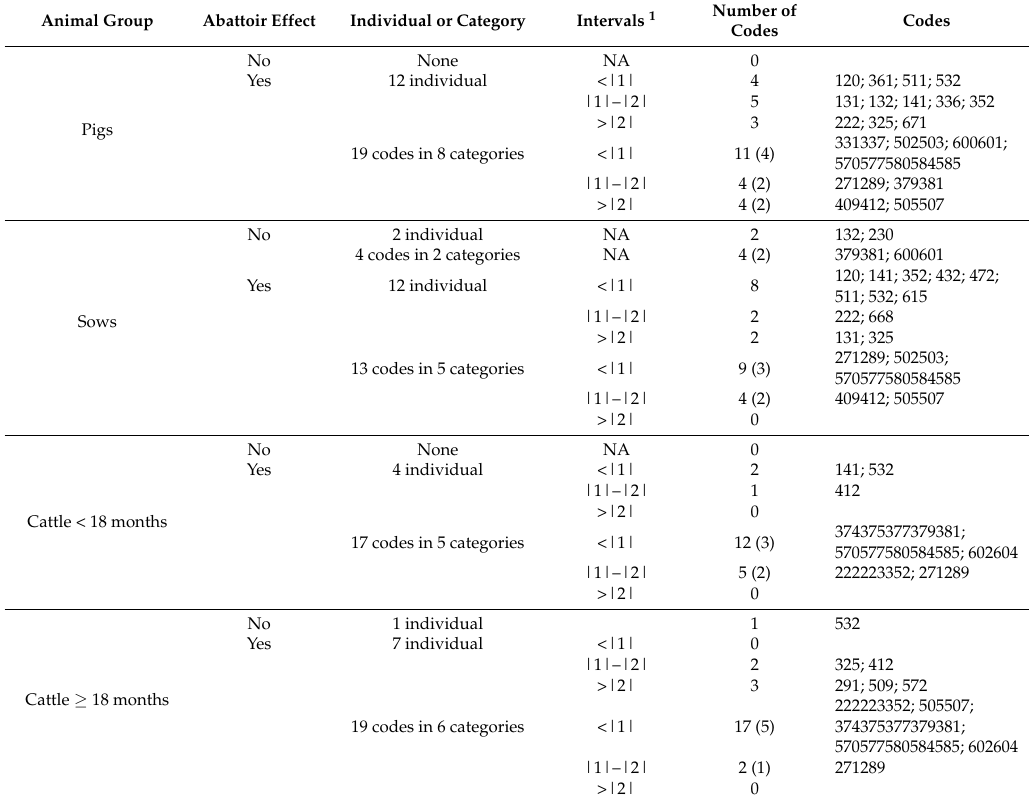
Table 7. Summary of random effect coefficient estimates (on the logit scale) modelled for individual meat inspection codes or categories of